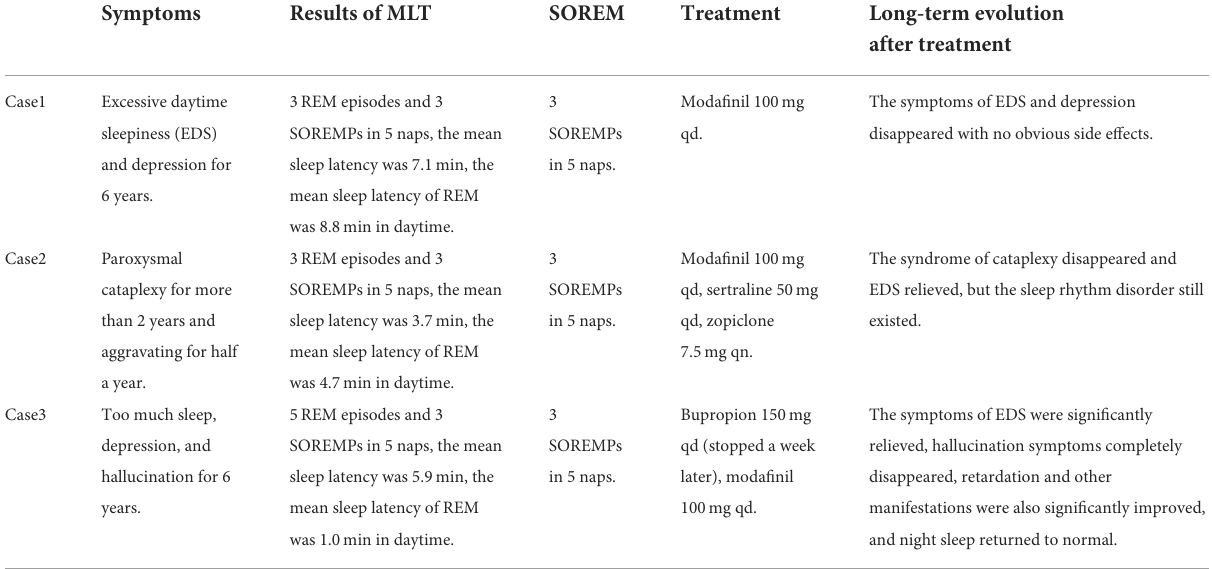
TABLE 1 Main characteristics of all three